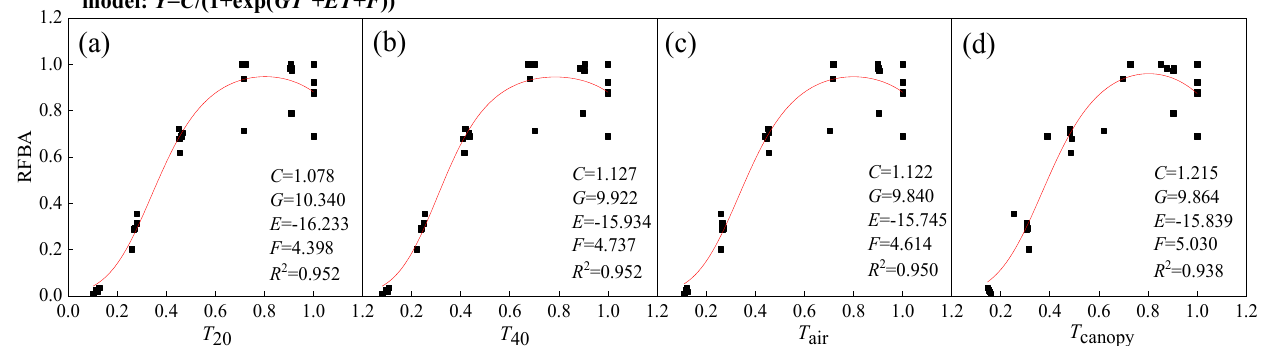
Figure 14. Simulations of RFBA based on the NR-logistic model with four relative effective accumu- lated temperatures from all plots in 2017: ( a ) T 20 ; ( b ) T 40 ; ( c ) T air ; ( d ) T canopy . Table 4. Calibration results and inter-annual differences of NR-logistic model parameters with T 20 , T 40 , T a ir , and T canopy in